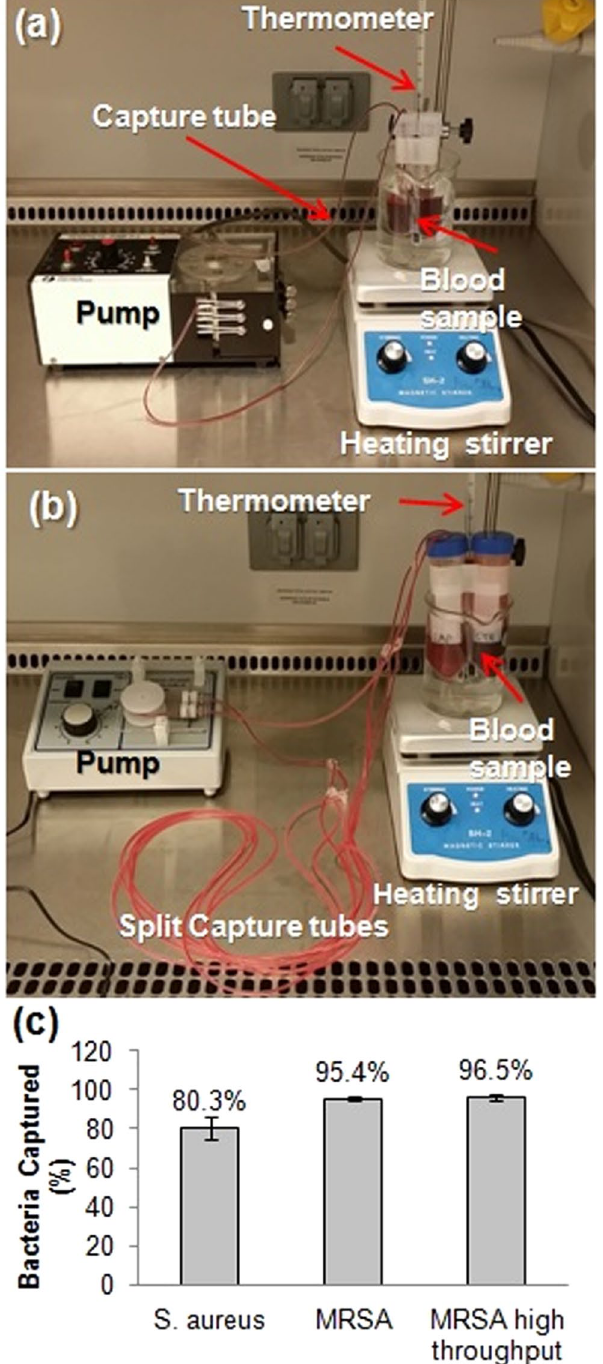
Figure 2. In vitro tube capturing. ( a ) Experimental set-up of 5 mL blood volume at 0.5 mL/min flow rate. ( b ) Experimental set-up for the high throughput experiments of 20 mL blood volume at 5 mL/min flow rate. ( c ) Summary of capturing efficiency presented in % captured bacteria compared to controls. 80.3 ± 5.6% of S. aureus with a starting concentration of ~10 7 CFU/mL was removed from 5 mL blood in 5 hours (n = 5), 95.4 ± 1.0% of MRSA from a starting concentration of ~104 CFU/mL was removed from 5 mL blood in 5 hours for (n = 5). 96.5 ± 1.6% of MRSA from a starting concentration of ~10 4 CFU/mL was removed from a high throughput condition, 20 mL blood at 5 mL/min flow rate in 5 hours (n =